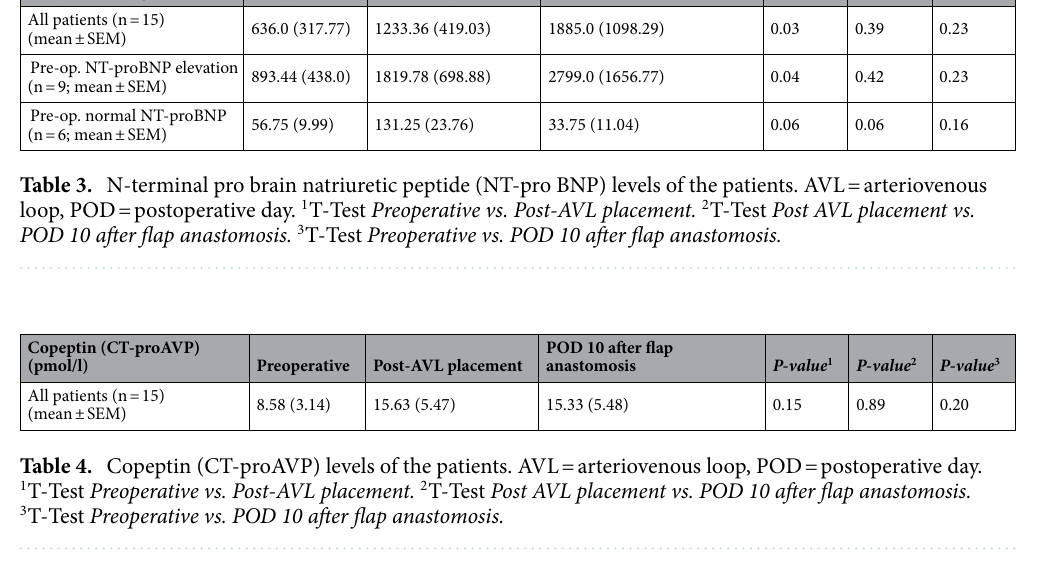
NT-pro BNP (pg/ml)